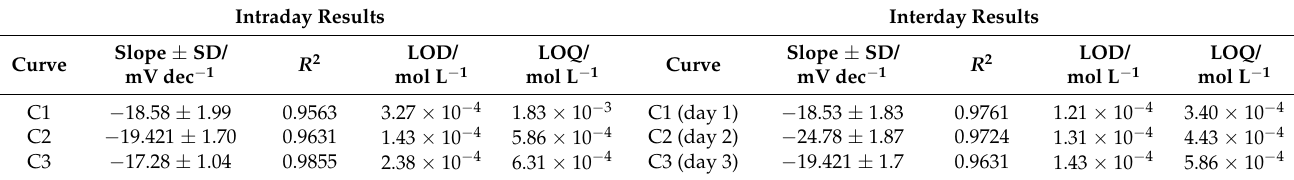
Figure 11. M1 interday testing ( n = 3). Table 4. M1 intra- and interday testing results in EB2.